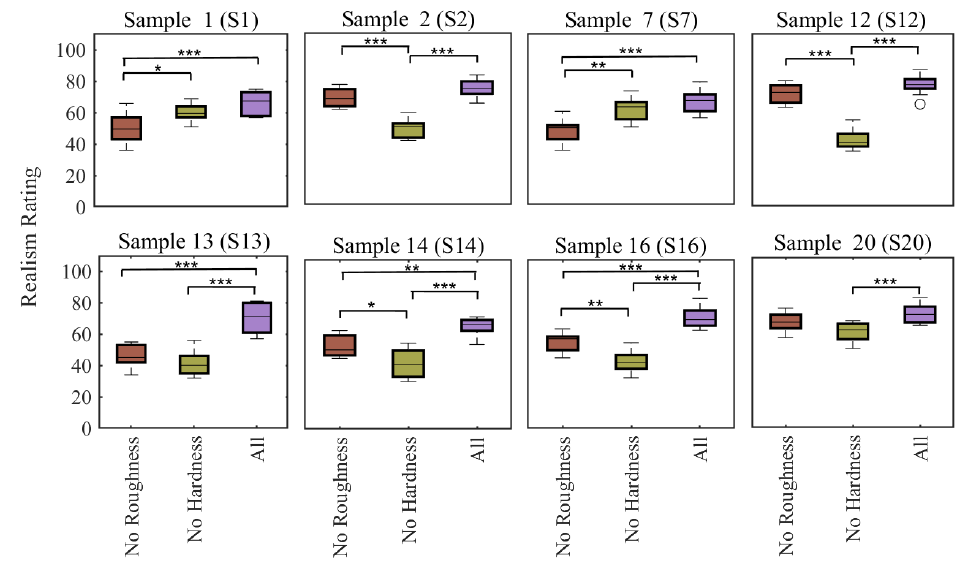
Figure 15. Comparison of realism ratings across the three rendering methods of each sample. (*** ≡ p ≤ 0.001, ** ≡ p ≤ 0.01, * ≡ p ≤ 0.05 )